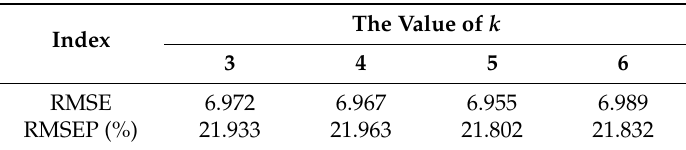
Table 3. Performance in the case of different value of